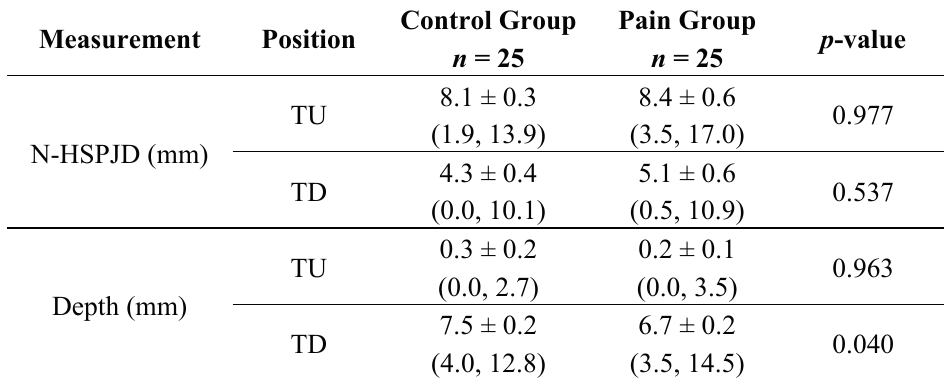
Table 2. Nipple position and depth of intra-oral space in the tongue up and the tongue down positions for Control group (mothers with no nipple pain) and Pain group (mothers experienced persistent nipple pain during